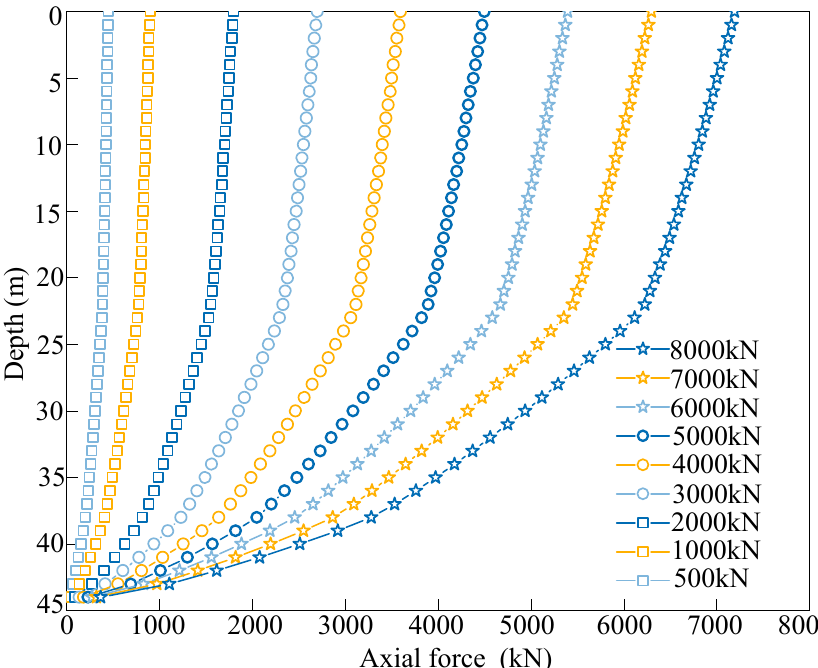
Figure 5. Relationship between pile axial force and pile top vertical load.